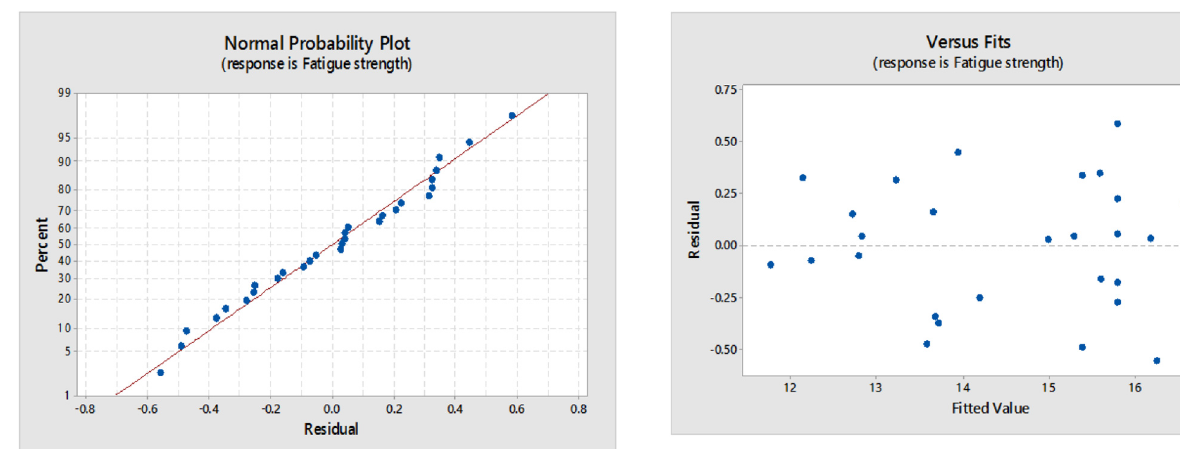
Fig. 9. Normal probability plots of residuals.